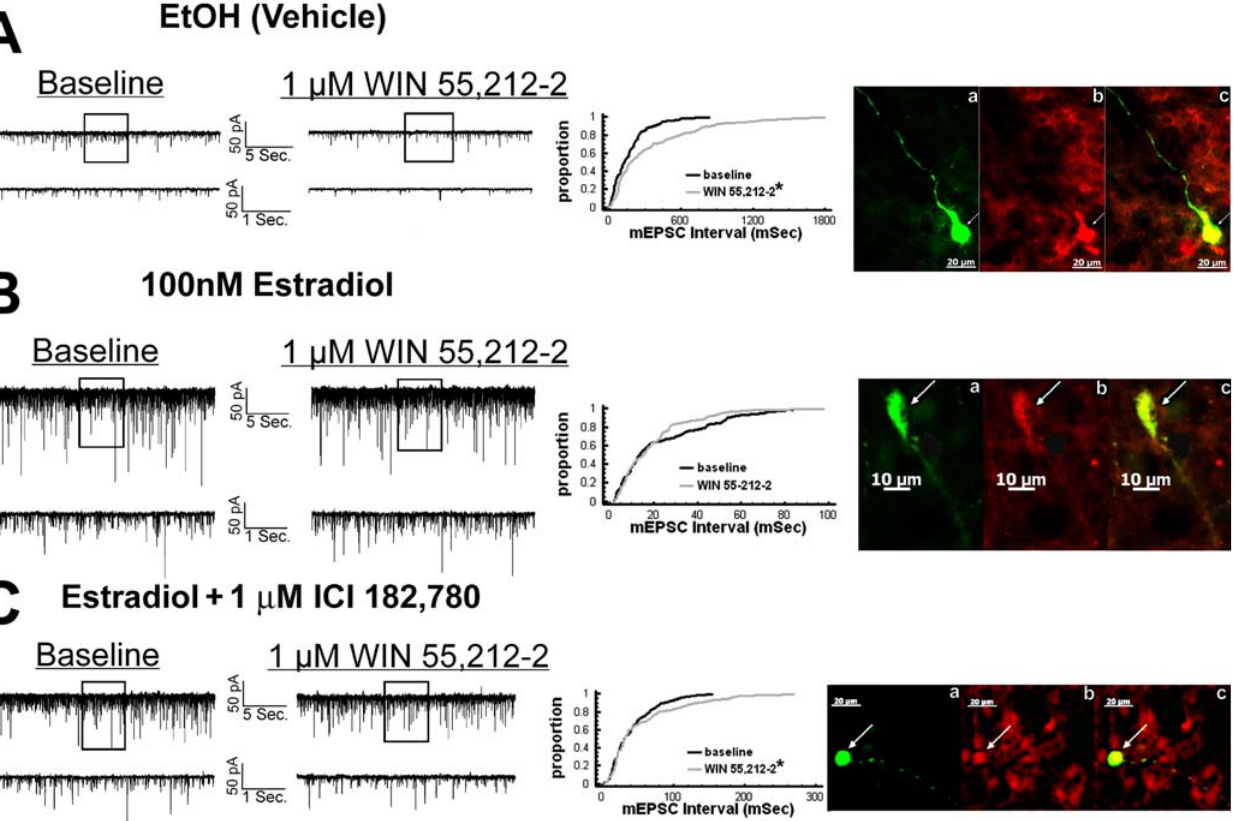
Figure 6. E rapidly attenuates the cannabinoid receptor agonist-induced presynaptic 2 inhibition of glutamate release onto POMC neurons via an ER receptor-mediated mechanism.